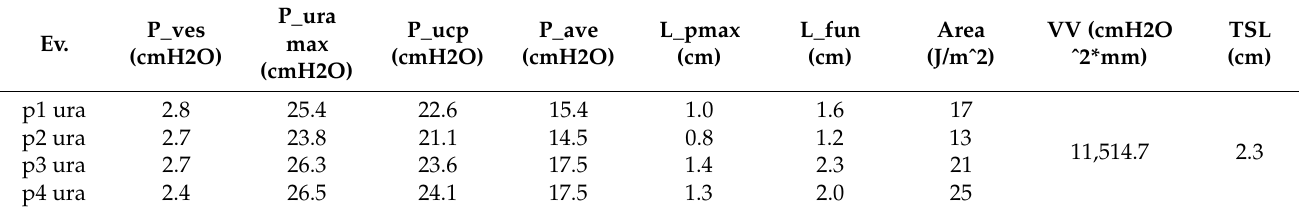
Figure 6. Rest profilometry. Table 3. Rest profilometry measurements